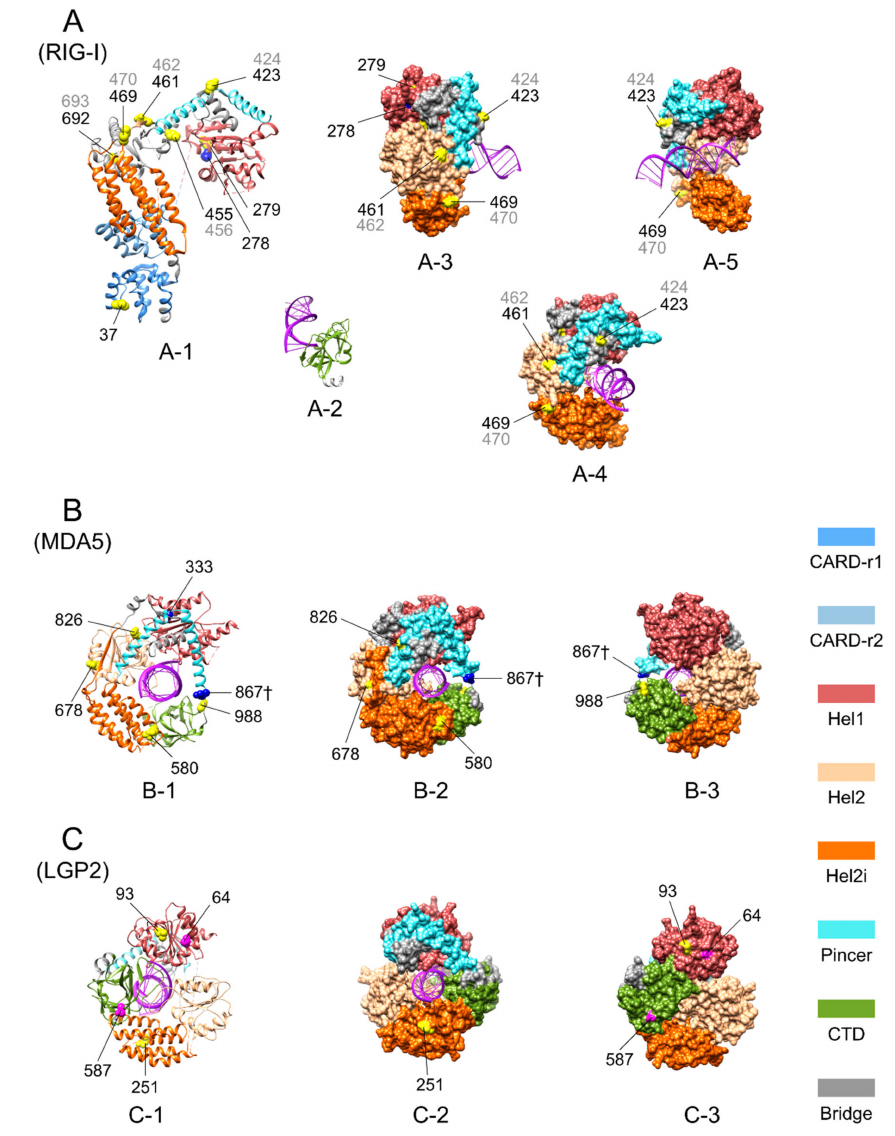
Figure 3. Three-dimensional (3D) structures of avian RIG-I-like receptors with some positively selected sites (PSSs) marked. Pervasive positively selected sites (PPSSs), the episodic positively selected sites (EPSSs) with specific substitutions in LGP2 of Galliformes, and the PSSs located identically in MDA5 and RIG-I are mapped on available 3D protein structure images of duck RIG-I, partial chicken MDA5, and LGP2 (the MDA5 image does not include the caspase recruitment domains (CARDs) region; some PSSs are within the missing regions of the images and thus cannot be shown). ( A ) Duck RIG-I. Original image PDB IDs: 4a2w for A-1, 4a2x for A-2 and 4a36 for A-3, A-4 and A-5. In ( A ), A-1 shows the ribbon diagram of domains except the C-terminal domain (CTD) and A-2 shows the CTD; A-3 to A-5 show surface displays of the helicase domain from various angles. ( B ) Chicken MDA5. Original image PDB ID: 5JCH. ( C ) Chicken LGP2. Original image PDB ID: 5JBJ. In ( B , C ), from left to right, the ribbon diagram, surface display diagram and the surface display diagram rotated 180 ◦ on the vertical axis are shown. Colors of domains are denoted in the bottom right of the figure. Sites marked in yellow or with † appended to the site number represent PPSSs; sites in magenta represent EPSSs with specific substitutions in LGP2 of Galliformes; sites in blue represent PSSs located identically in RIG-I and MDA5. Marked sites are shown with the sphere display of side chains for the purpose of highlighting. Site numbers pointed to marked sites correspond to the chicken sequence for MDA5 and LGP2, to the duck sequence in black, and to the goose sequence in grey if different from that of duck for